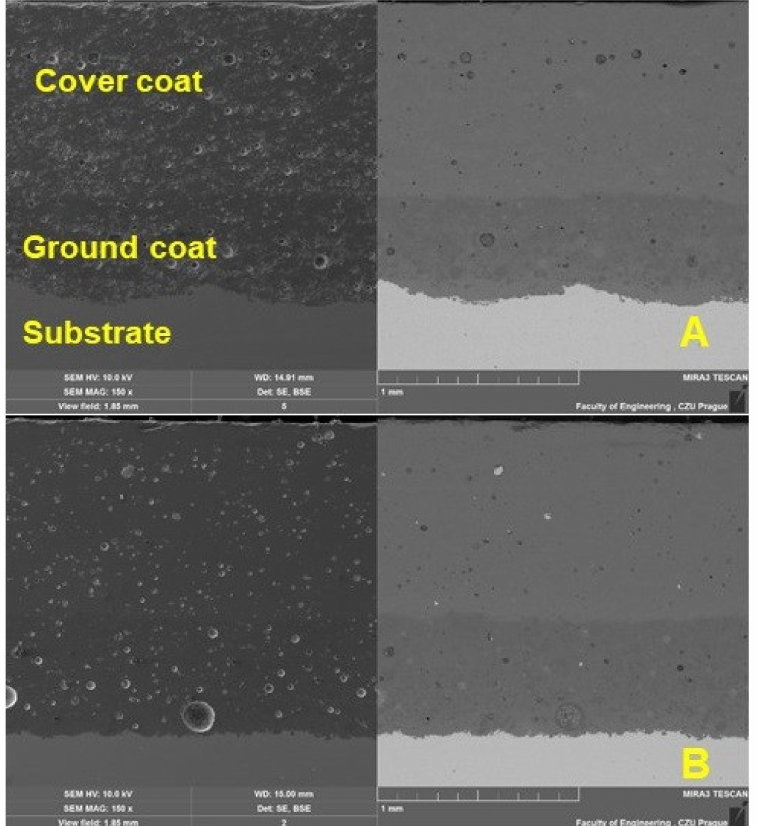
Figure 4. SEM analysis of a section of the test specimen before wear (SE Oxford detector—left, BSE Oxford detector—right): ( A ): original enamel (MAG 150 × ), ( B ): renovated enamel applied by local heating (MAG 150 ×